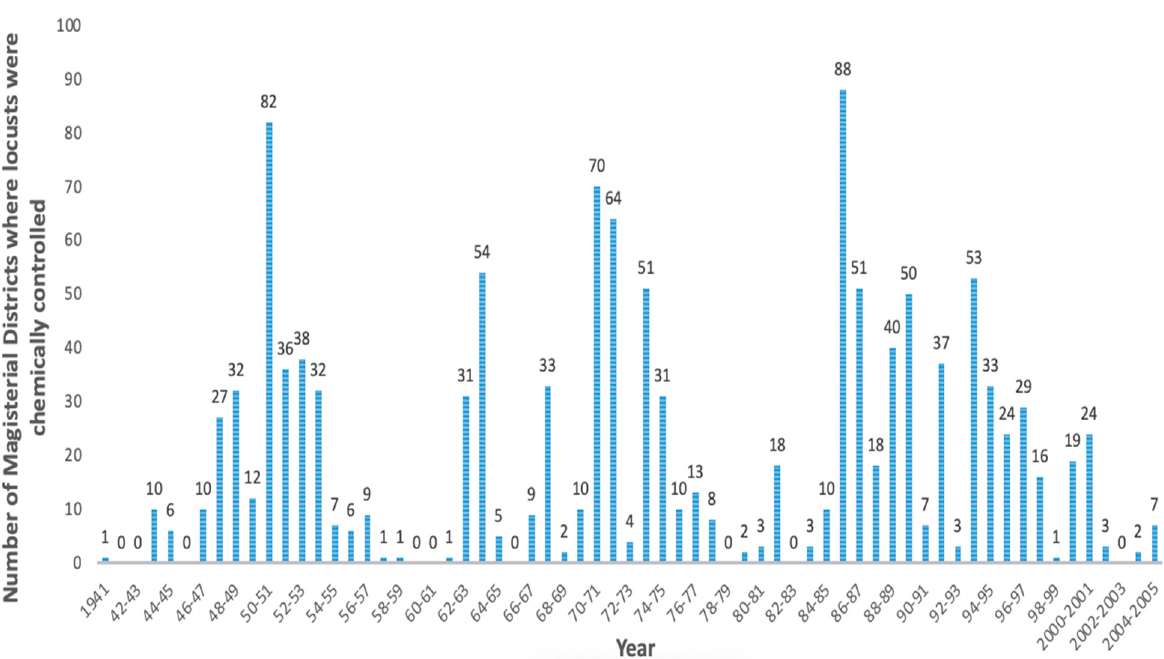
Figure 2. Number of Magisterial Districts that reported brown locust campaigns per locust season in South Africa, Namibia and Botswana between 1941 and 2005. Data obtained from Lea [3,22] for the period 1941–1954, from Lea [13,22] for the period 1954–1969, from annual reports of the South African National Dept. Agric. between 1970 and 1984, and from weekly locust control reports from the South African Dept. Agric. for the period 1984–2005. Data for Namibia and Botswana from Lea [22] and from Dept. Agric. reports from 1985 to 2005.